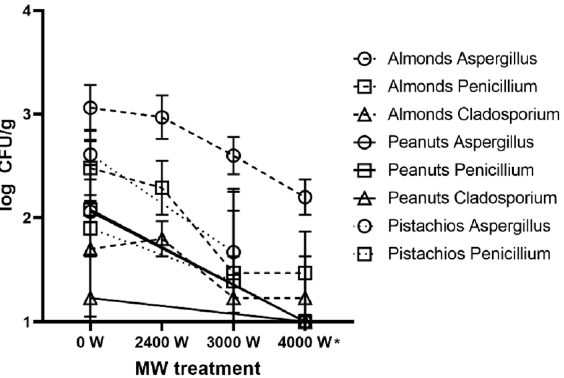
Figure 1. Effect of MW treatment on the mould genera representation and their counts (in log CFU/g, * significantly different values at p <